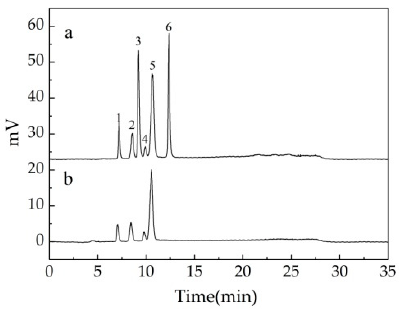
Figure 6. HPLC chromatogram of standard monosaccharides and hydrolyzed P-IIa. ( a ) Standard monosaccharides (1: rhamnose, 2: arabinose, 3: fructose, 4: glucose, 5: galactose, 6: sucrose). ( b ) HPLC chromatogram of hydrolyzed P-IIa.